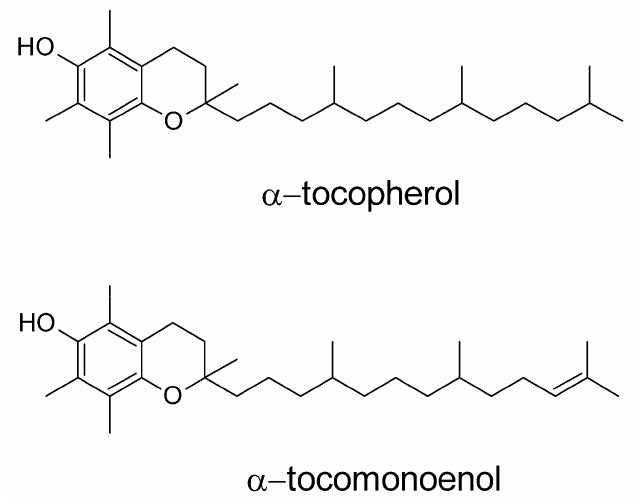
Figure 1. Chemical structures of α -tocopherol and α -11 (cid:48)